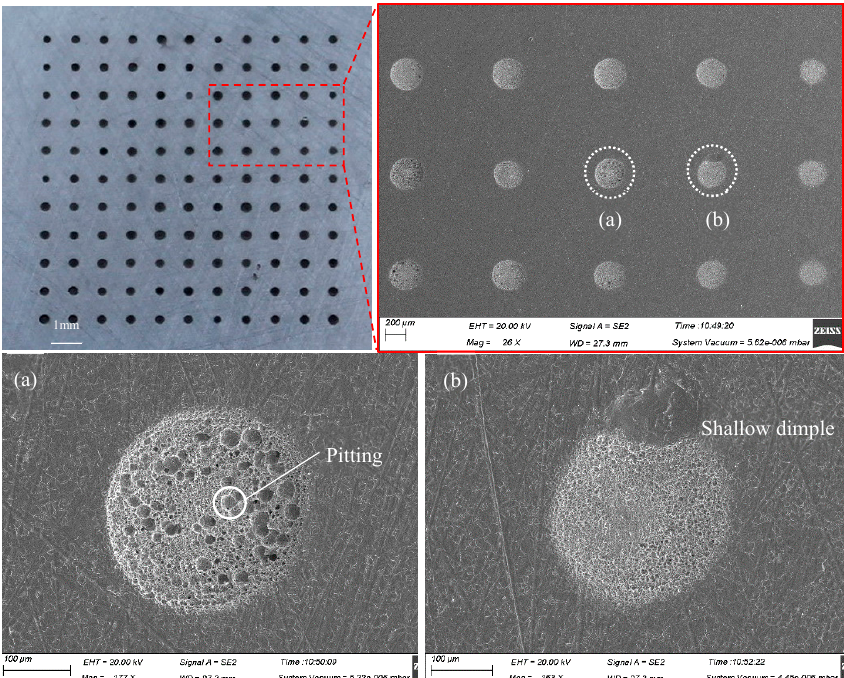
Figure 13. Morphologies of micro ‐ dimple arrays machined in the double ‐ travel mode and with the magnetic field (double ‐ travel time of 0.3 (cid:3400) 2 s, 6.5 V).